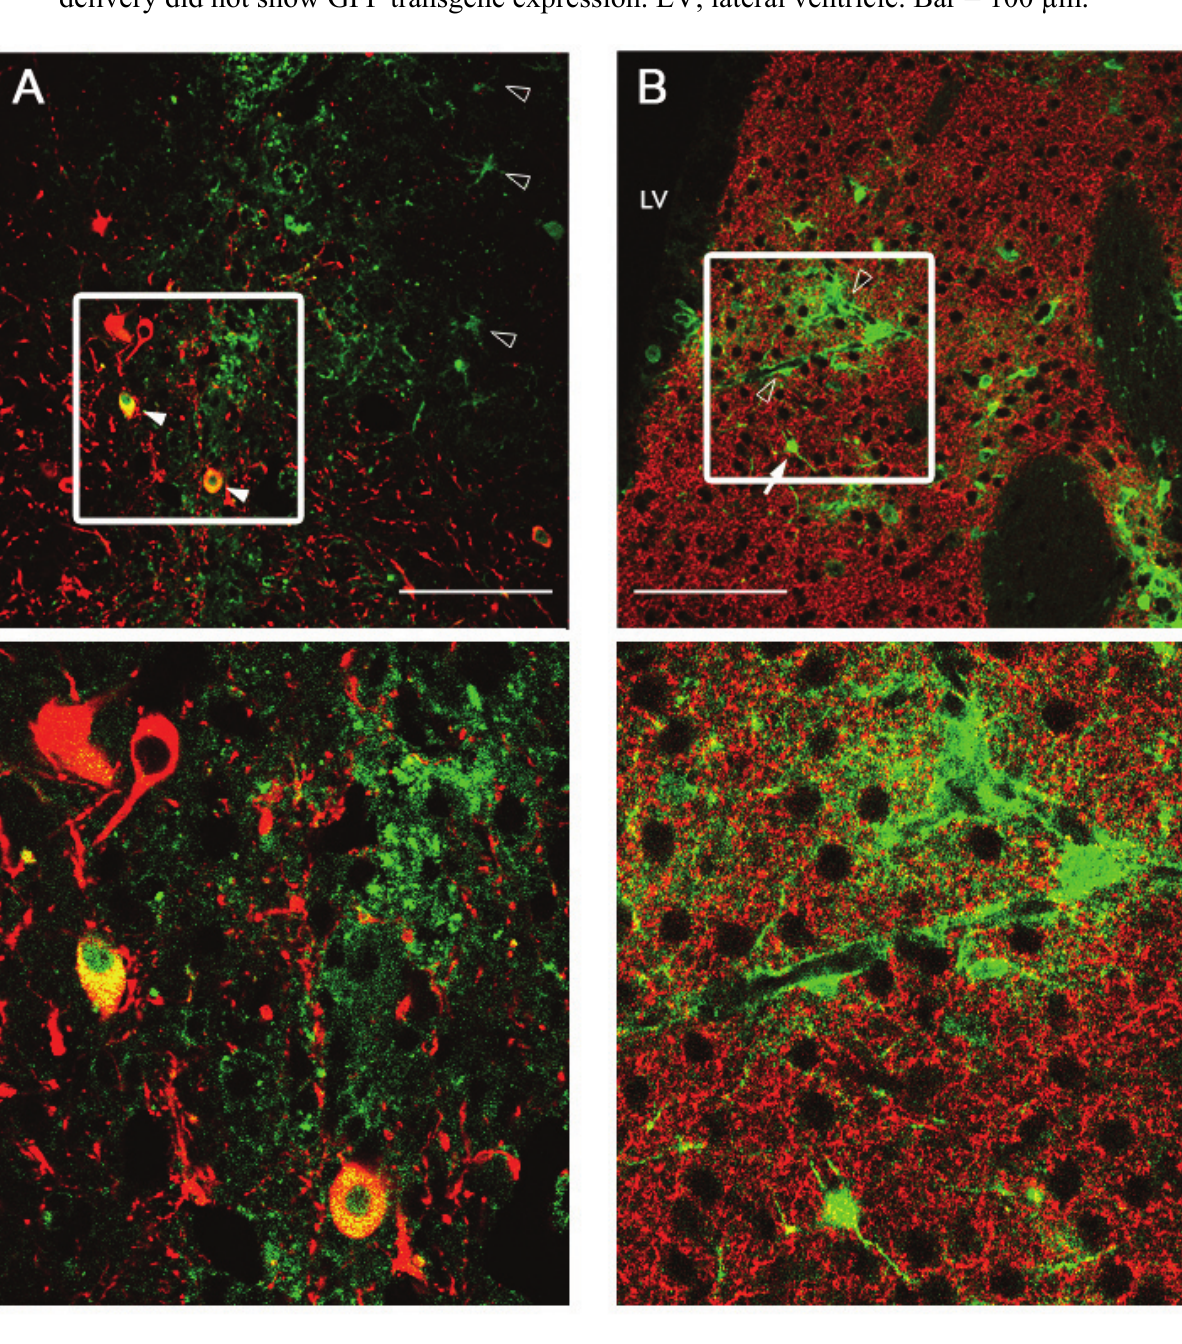
Figure 4. Pattern of Ad5-CBAp-GFP-WPREpA (CGW)-mediated GFP expression of in the substantia nigra (SN) and striatum (STR). Confocal immunohistochemical assessment of unmodified Ad5-CGW gene expression at the injection site two weeks after delivery to either SN ( A ) or STR ( B ) shows GFP transgene expression in a broad range of cell types, including cells with neuronal and astrocytic morphology, consistent with prior reports. Green = GFP expressing cells. Red = TH-positive neurons (A, TH-positive cell bodies in SN; B, TH-positive axon projections in STR). Solid arrowheads indicate GFP-expressing TH-positive neurons in the substantia nigra pars compacta (SNc). Open arrowheads indicate GFP-positive cells with astrocyte morphology. Solid arrows indicate GFP-positive cells with neuronal morphology in the STR. Inspection of presynaptic regions to the site of delivery did not show GFP transgene expression. LV, lateral ventricle. Bar = 100